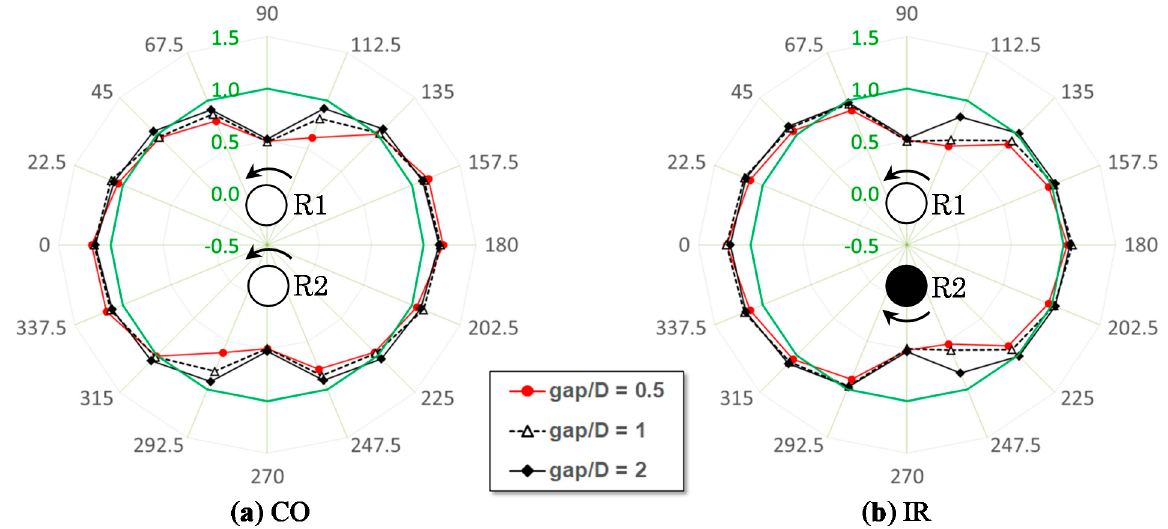
Figure 15. 16-direction dependence of average of normalized power: ( a ) CO configuration; ( b ) IR configuration.